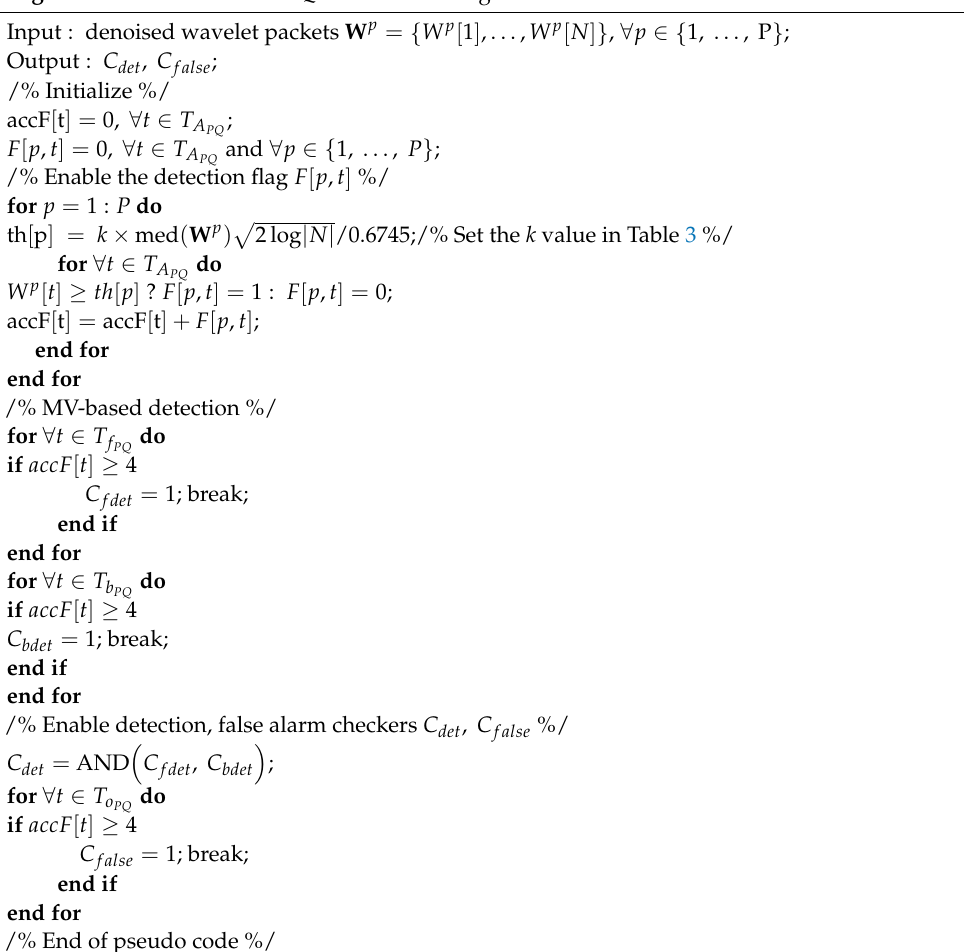
Algorithm 1. WPTM-based PQD detection using MV metric.